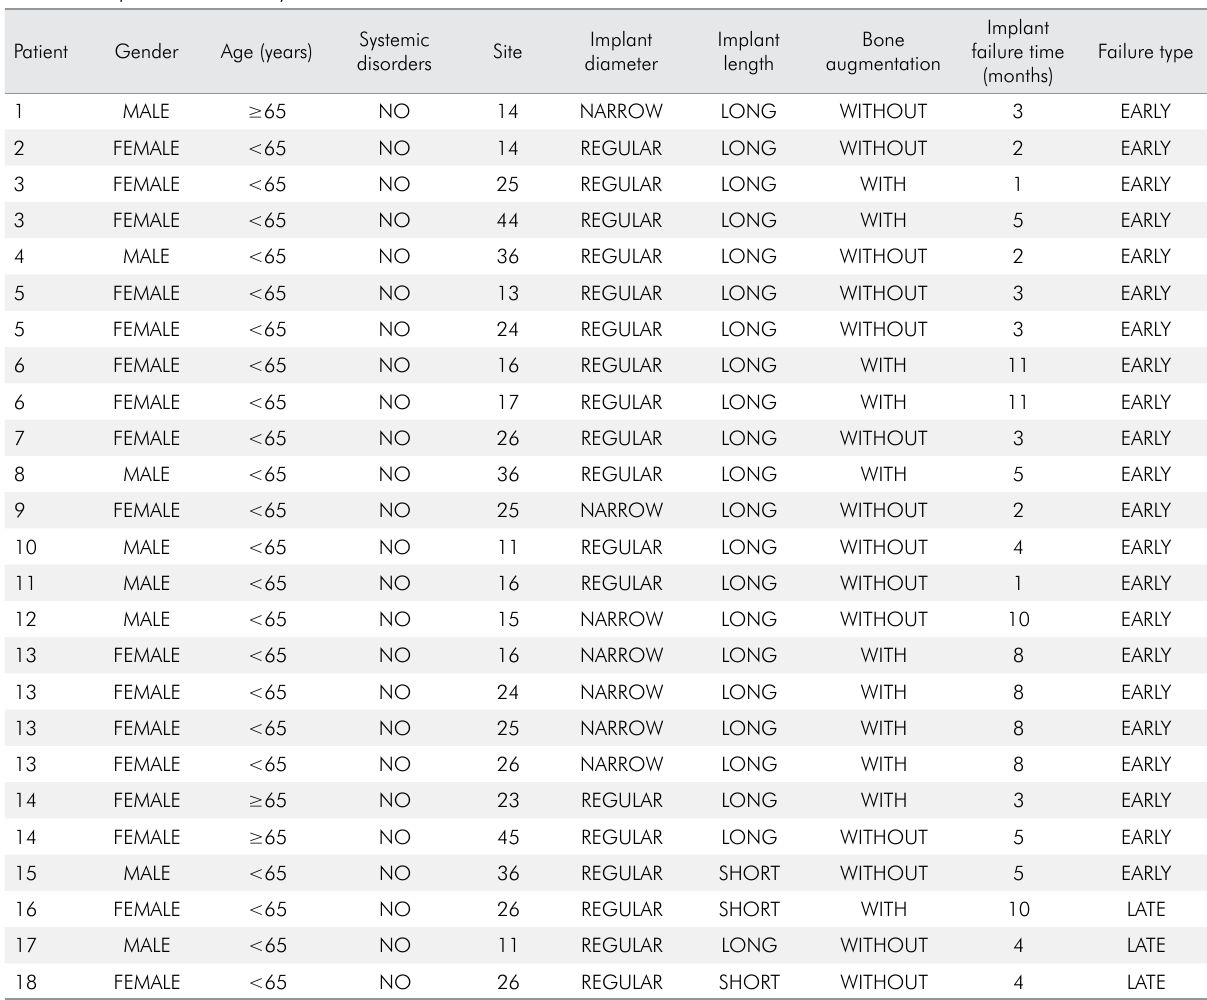
Table 3. Implant failure analysis